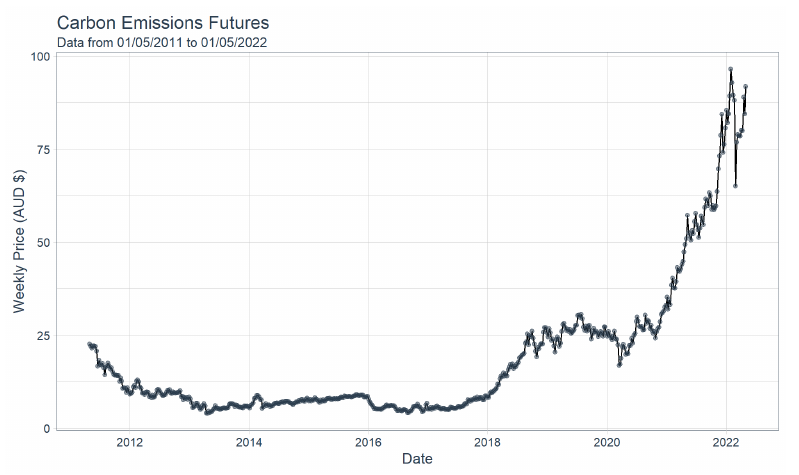
Figure 6. Time Series